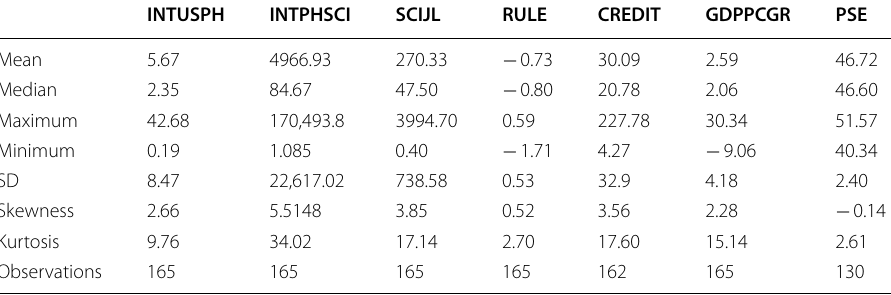
Table 3 Multicollinearity test. Source : computed by the authors Variable lintusph lintphsci